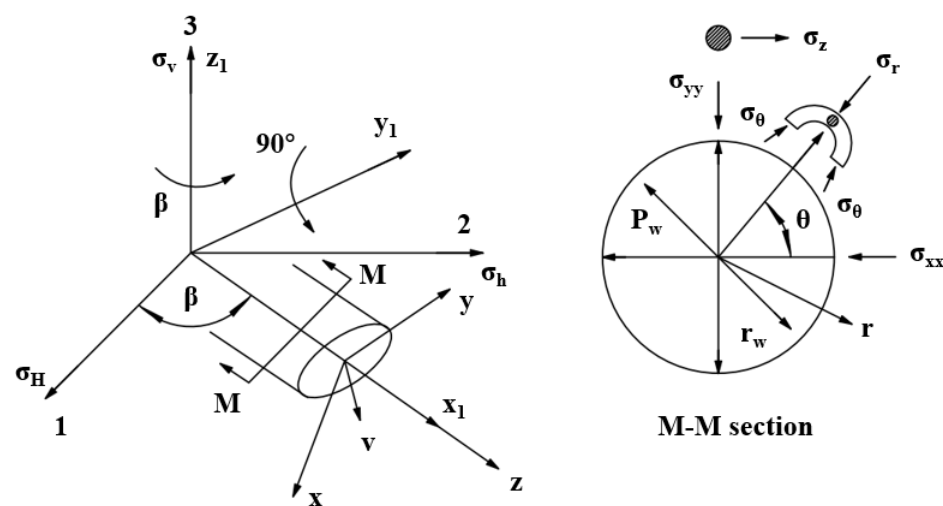
Figure 1. Horizontal well shaft orientation and original in situ stress coordinate transformation.